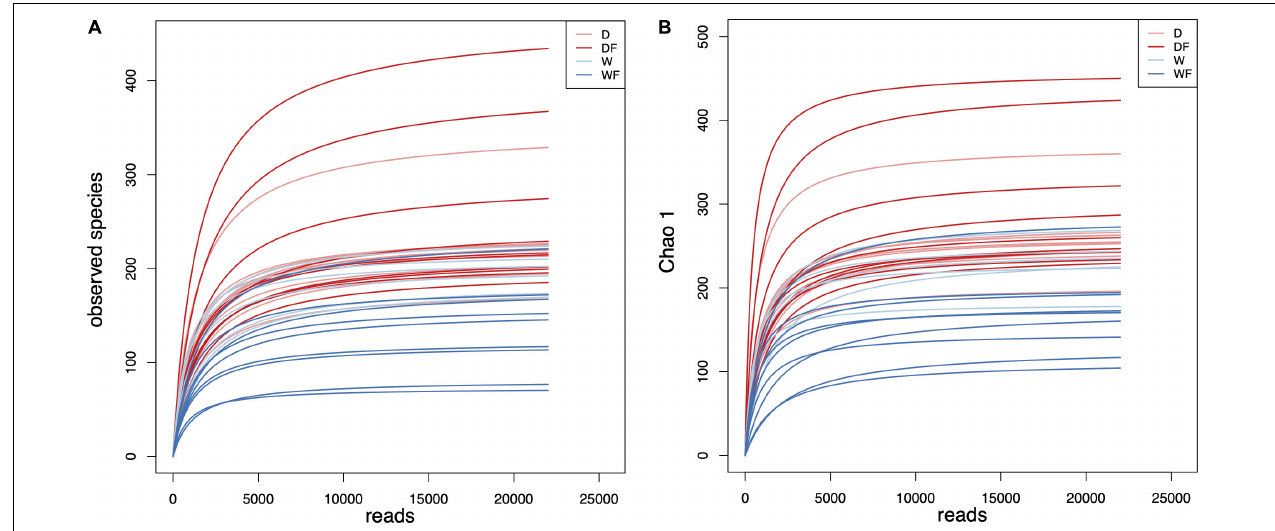
FIGURE 1 | Rarefaction curves of (A) observed species and (B) Chao 1 index for gut microbiota diversity of mice transplanted domestic pig fecal bacteria and feed a low-fiber diet (D) or high-fiber diet (DF), transplanted wild boar fecal bacteria and feed low-fiber diet (W) or high-fiber diet